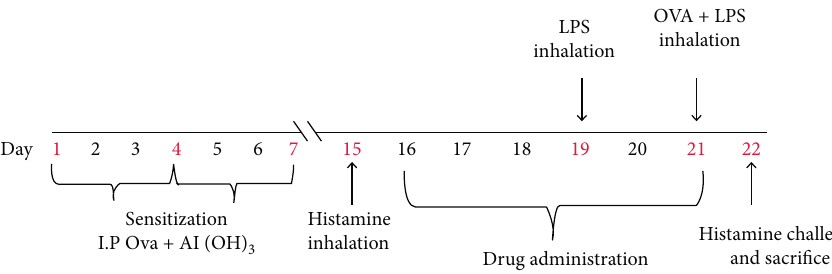
Figure 1: A schematic representation of the LPS-OVA-induced steroid-resistant asthma in Guinea